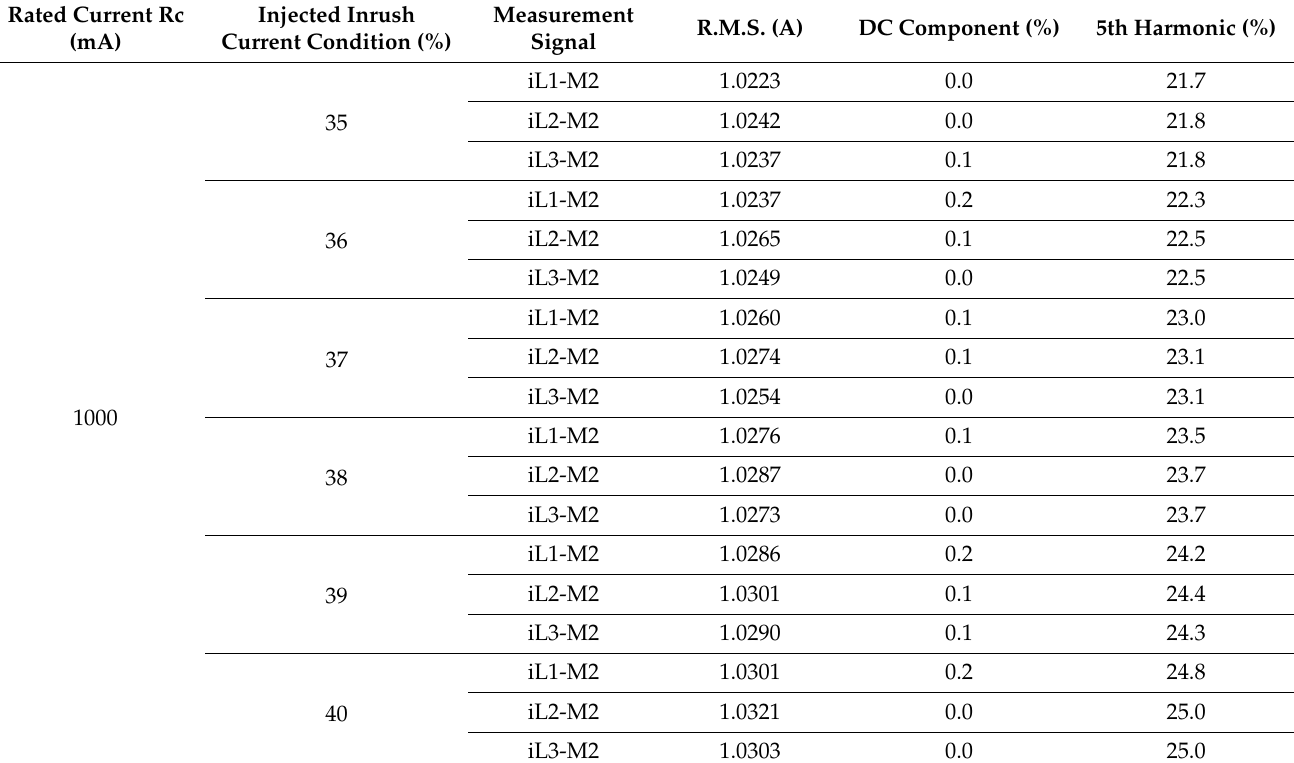
Table 2. Fifth harmonics blocking in lines (L1, L2, &